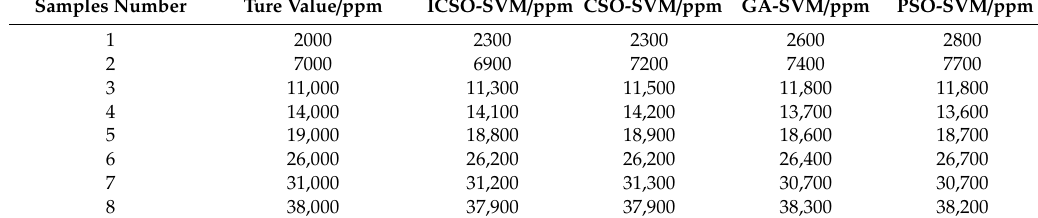
Table 3. The predicted results of the four models.